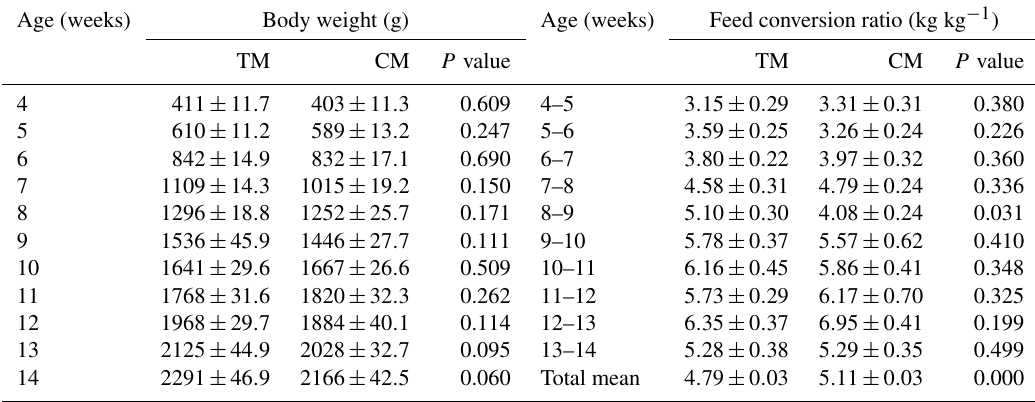
Table 2. Growth performance of guinea fowl in response to diets based on nutrient specifications for three- or two-phased diets (mean ± SEM).